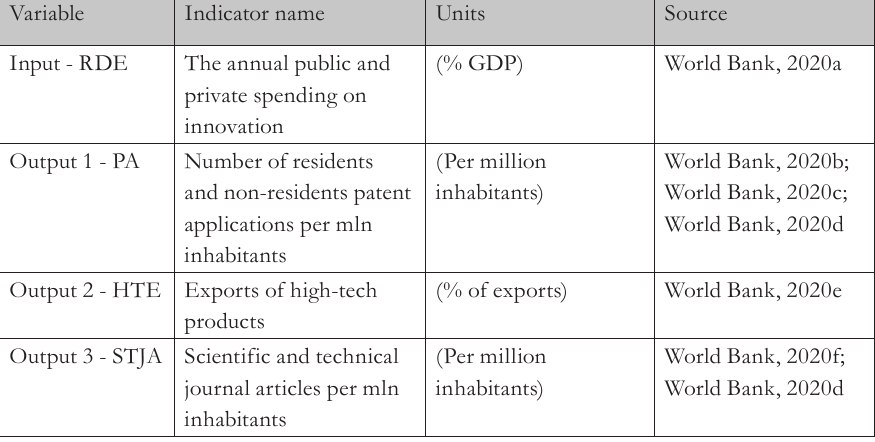
Tab. 2 – Indicators and Sources. Source: World Bank (2020a –